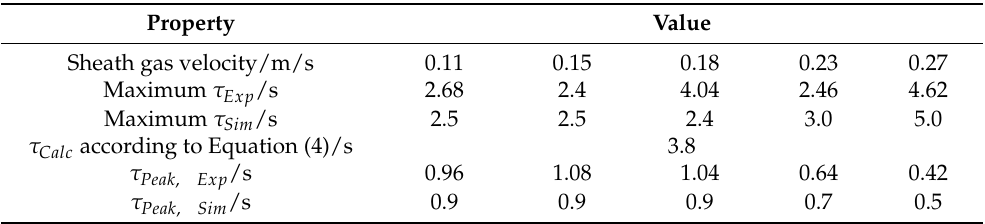
Table 4. Experimental and numerical peak and maximum particle residence times under different operating